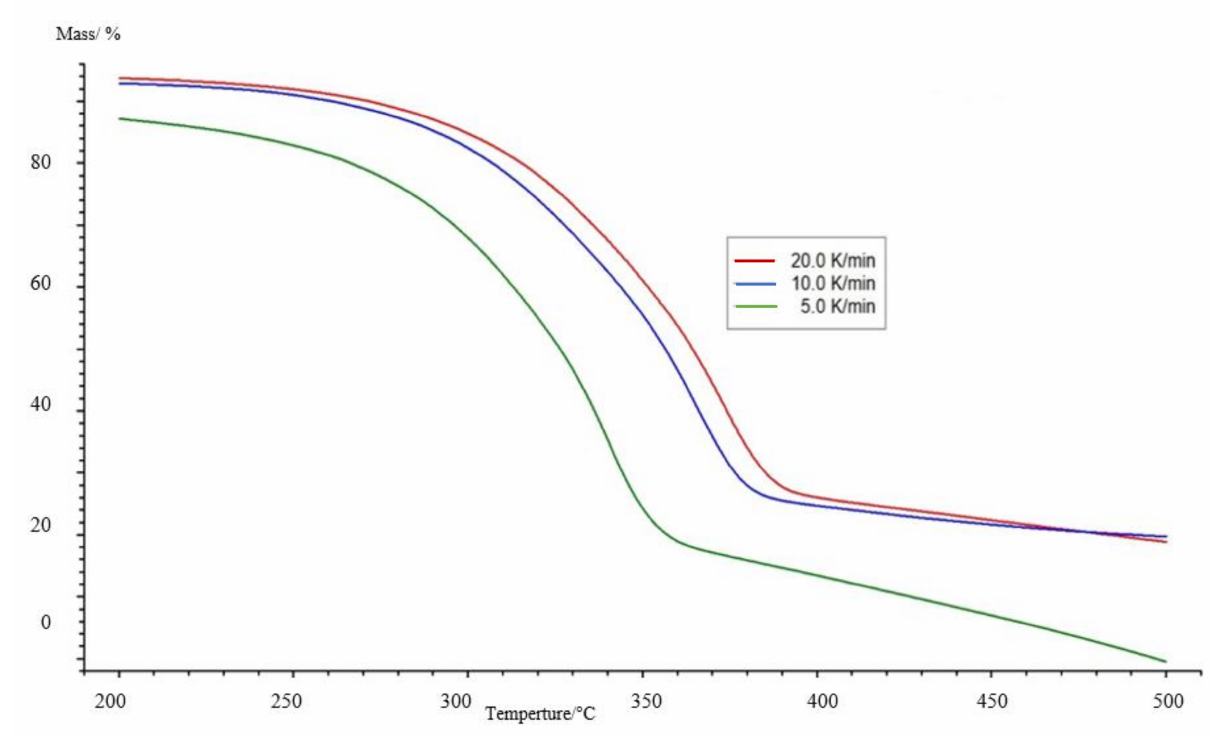
Figure 9. TG curves for three heating rates for pine wood.